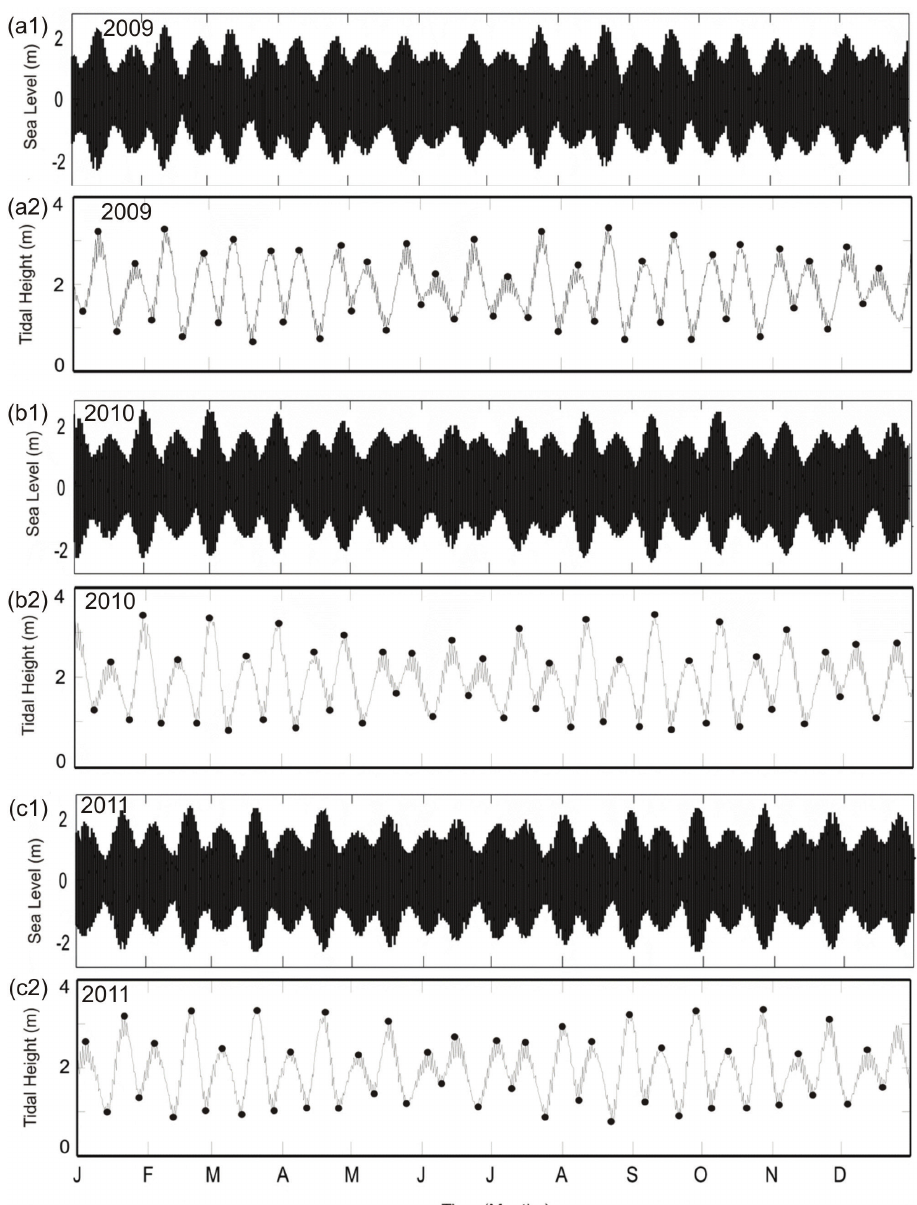
Figure 3 - Observed hourly sea level time series (a1, b1 and c1) and respective tidal height (a2, b2 and c2) at Fortaleza for the years 2009 (a) , 2010 (b) and 2011 (c) . The black dots at tidal height time series indicate the extreme higher and lower spring and neap tide